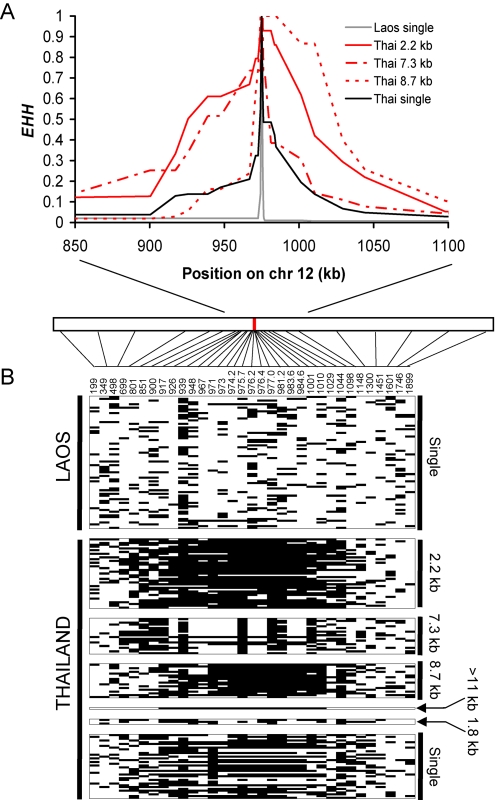
Haplotype structure and LD decay around gch1.(a) Plots of EHH for markers flanking gch1 from Thailand and Laos. In Thailand, EHH is plotted for the three predominant amplicon types (2.2, 7.3 and 8.7 kb). EHH for chromosomes with single copies of gch1 from both countries is shown for comparison. (b) Visual representation of LD. Microsatellite data was reduced to binary form by coloring the predominant allele in black and all other alleles in white. The 33 loci typed are arranged in order across the chromosome, while samples are arranged in rows. The country of origin of each sample is shown on the left, while the amplicon type (Figure 2) is shown on the right.